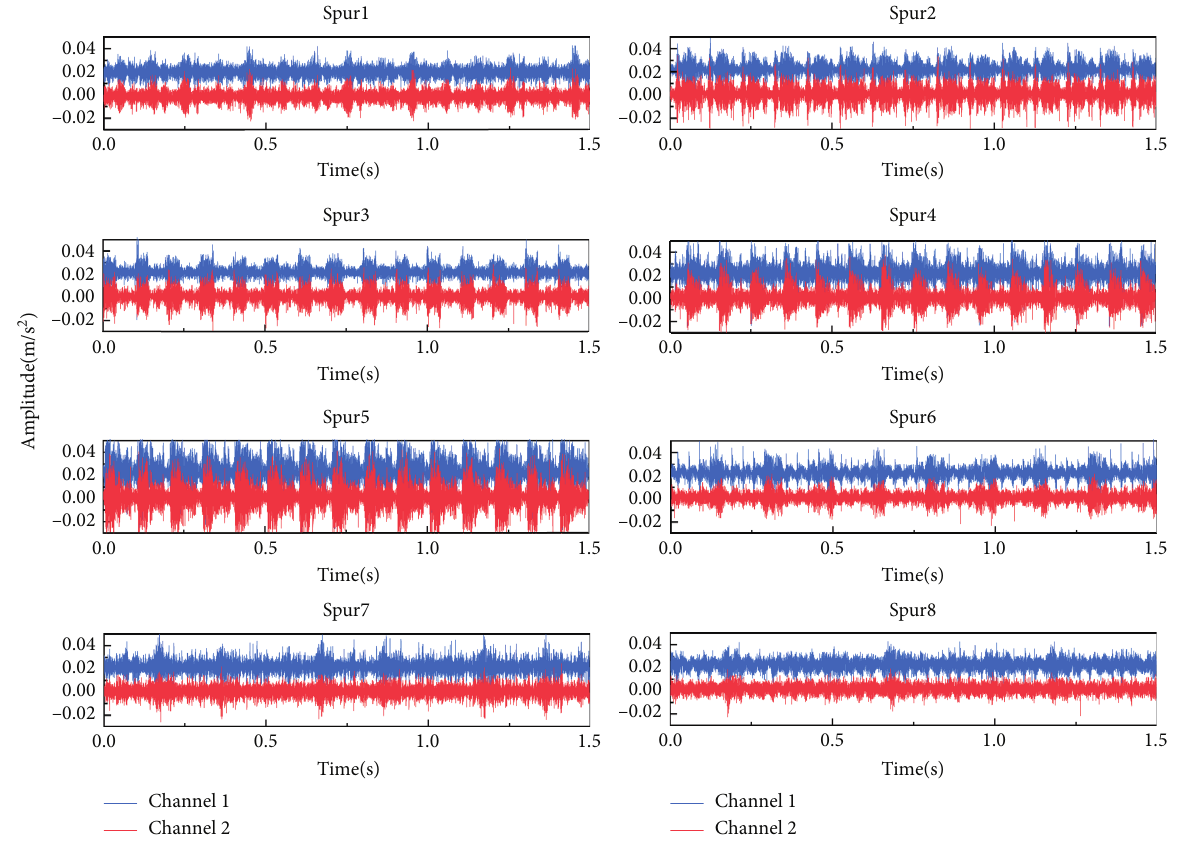
Figure 5: Partial data of the gearbox data set. Table 1: The detailed conditions of each part corresponding to the 8 working conditions of the